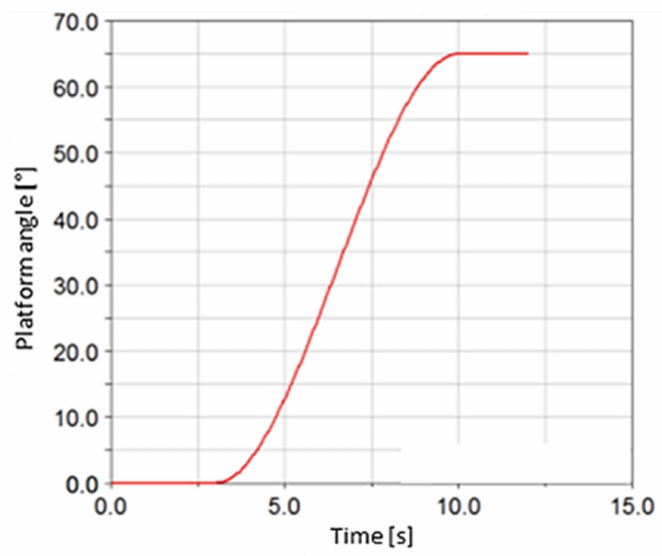
Figure 3. Tilt platform progress—platform lift angle as a function of